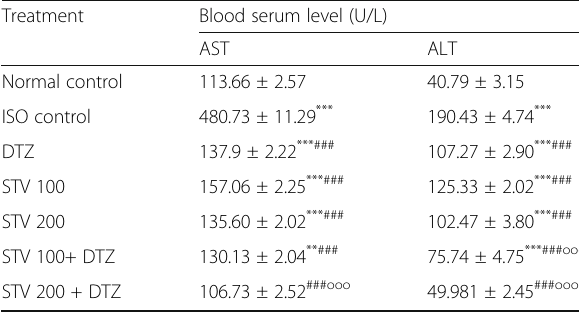
enzyme biomarkers in isoproterenol-induced myocardial infarction